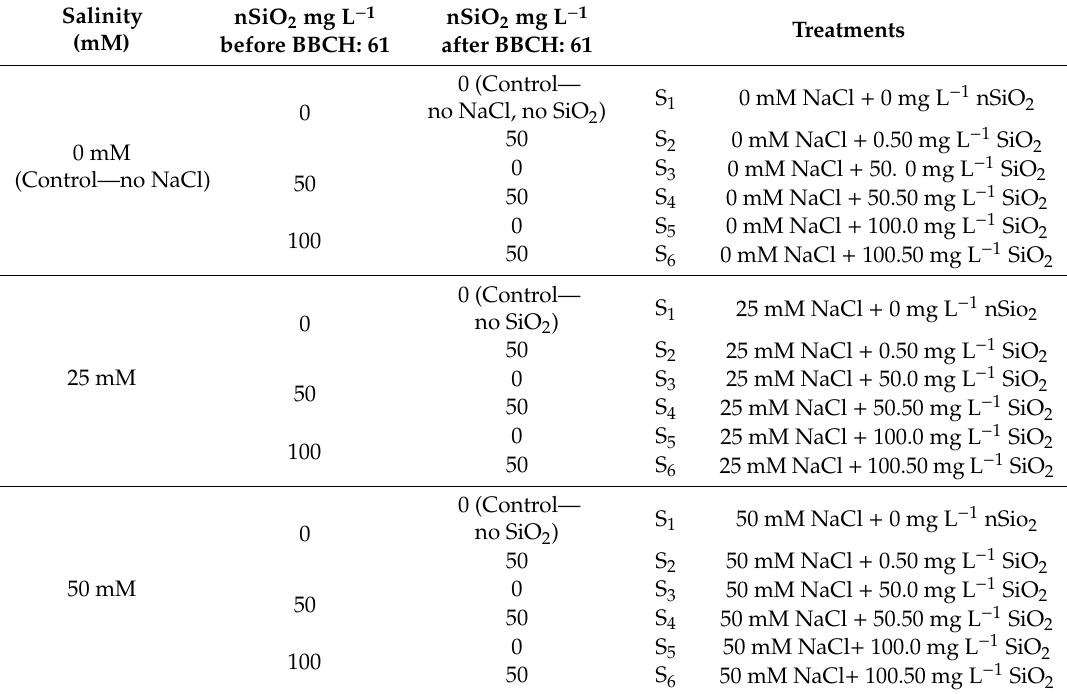
Table 1. Combinations of nano-silicon dioxide and salinity stress treatments